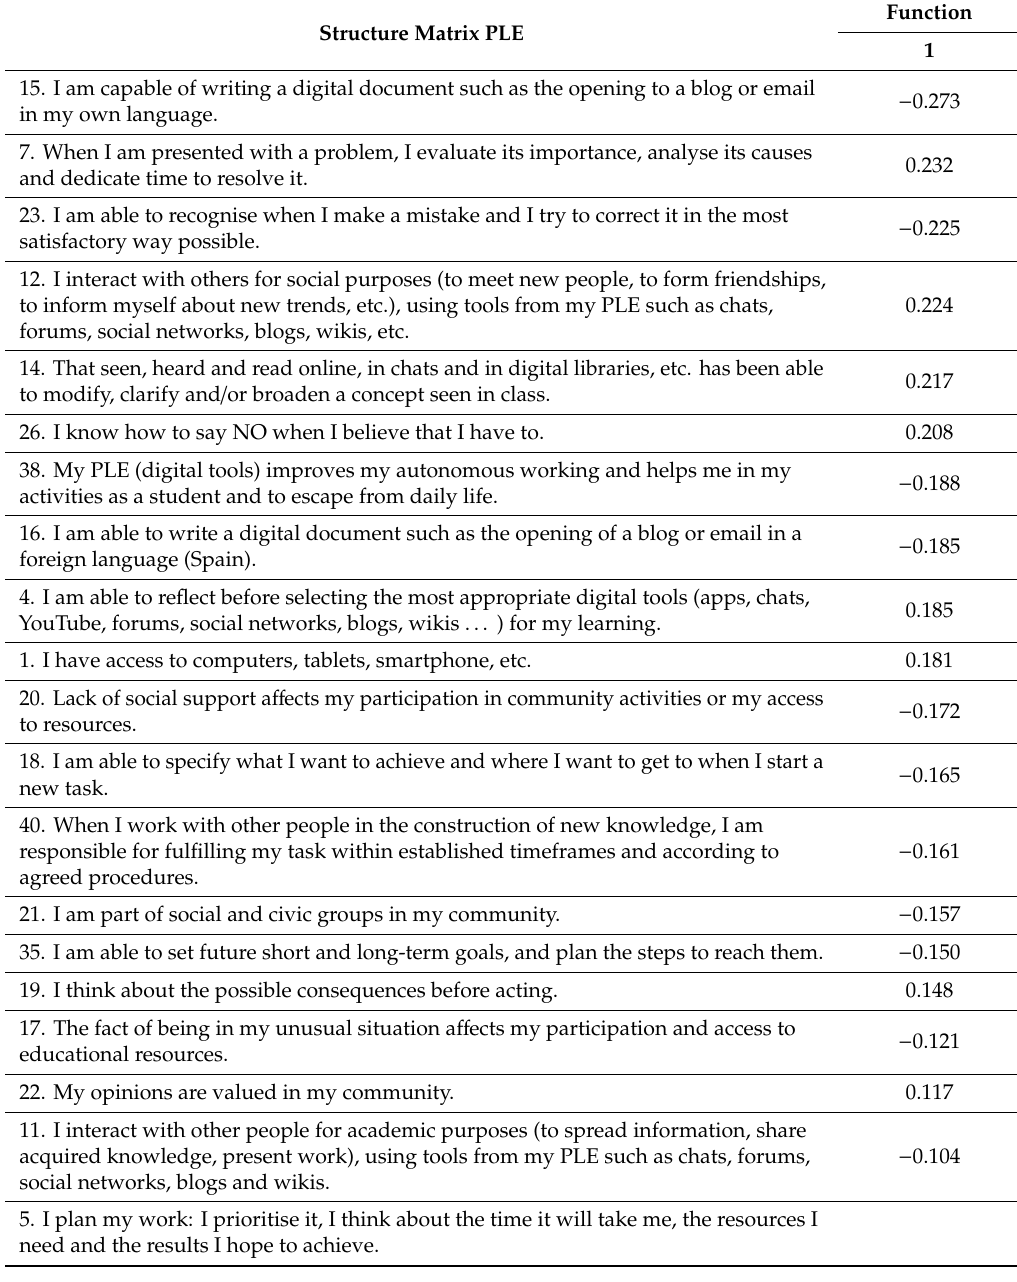
Table 5. Structure